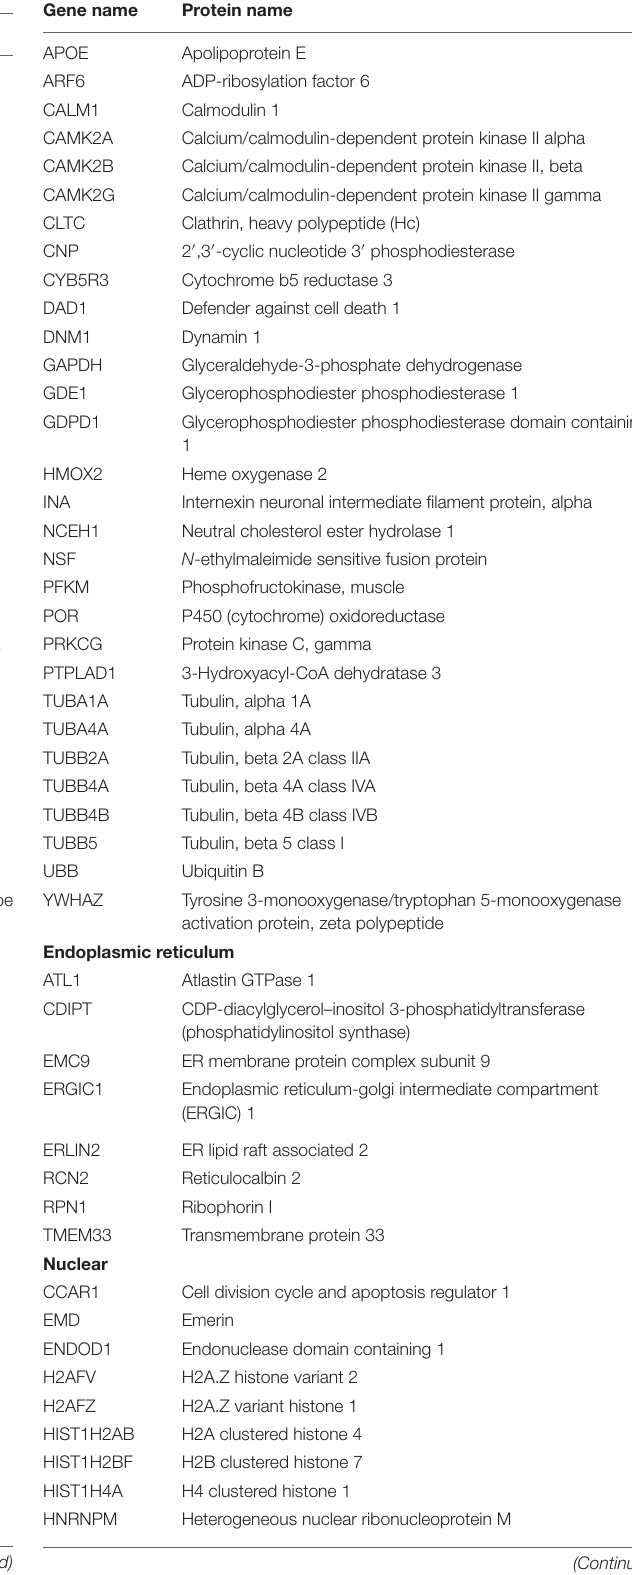
TABLE 1 | Protein ontology of proteins in ACVs identified with LC–MS/MS using gene ontology